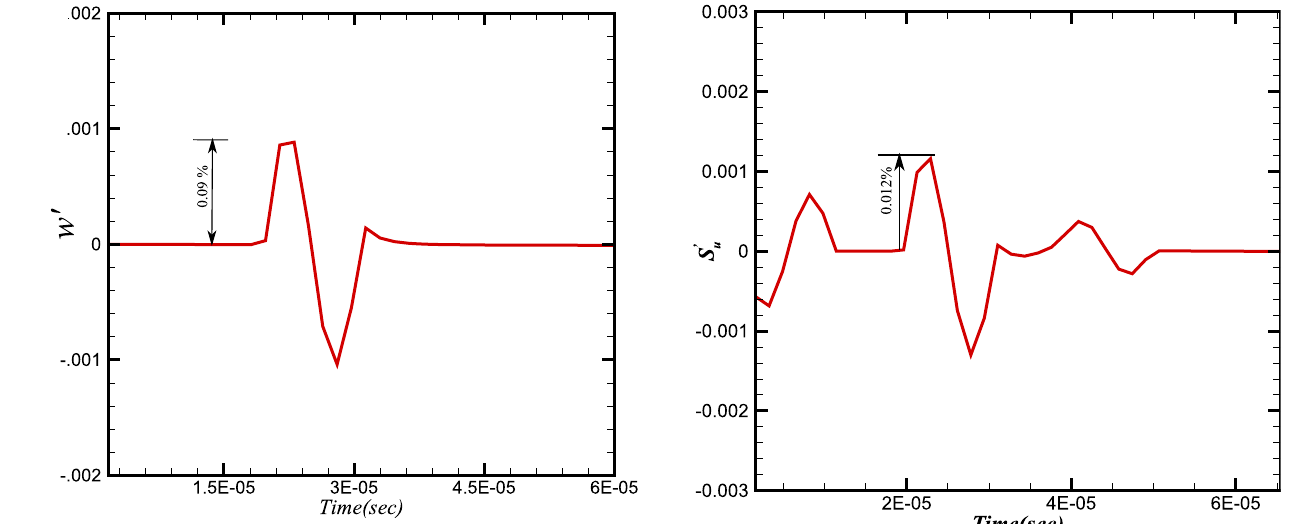
Figure 8. Relative change in burning velocities.